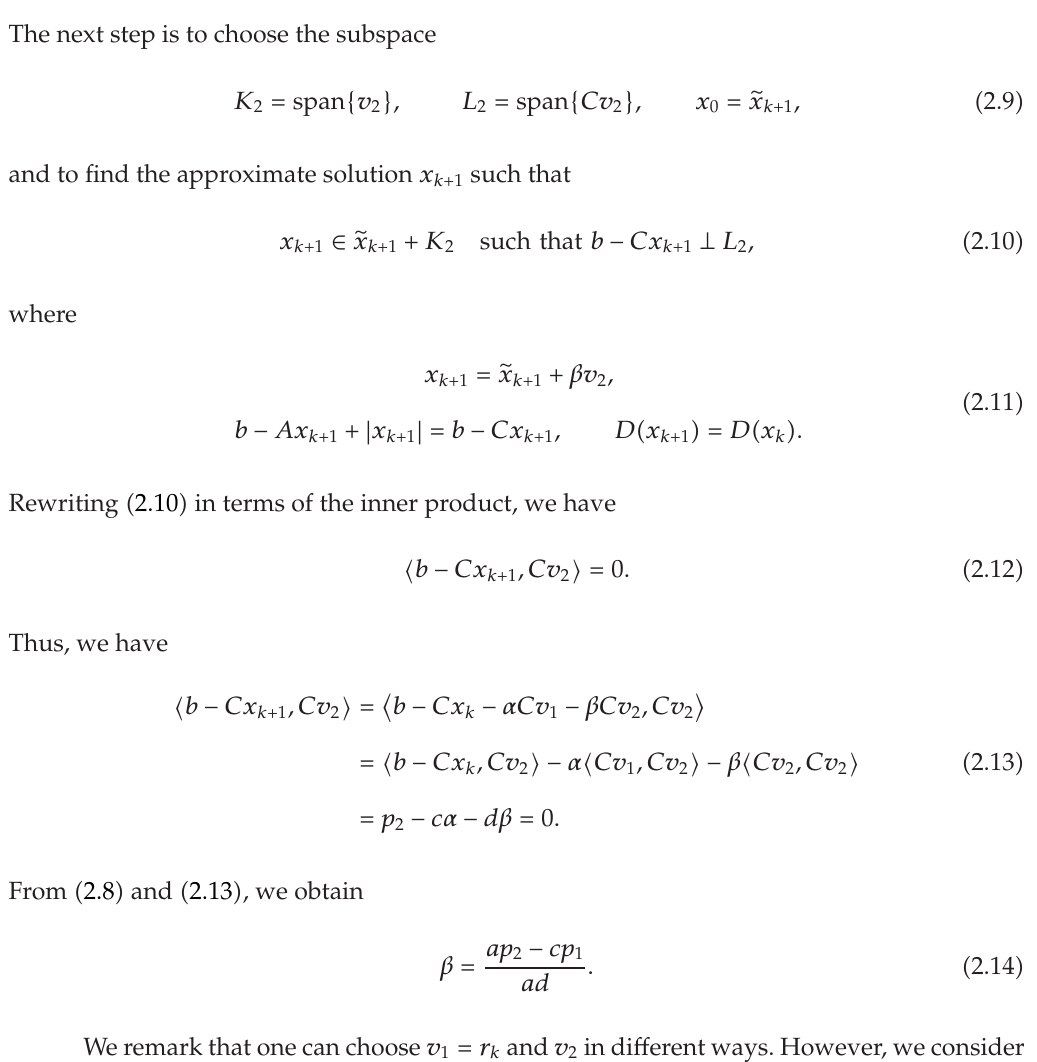
Algorithm 2.1. Choose an initial guess x 0 ∈ R n